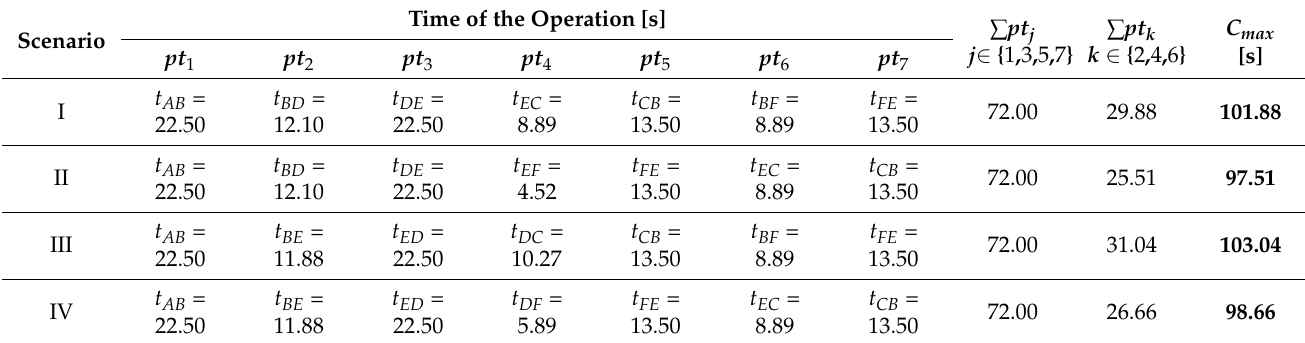
Table 3. The times of individual tasks of the robot depending on the work